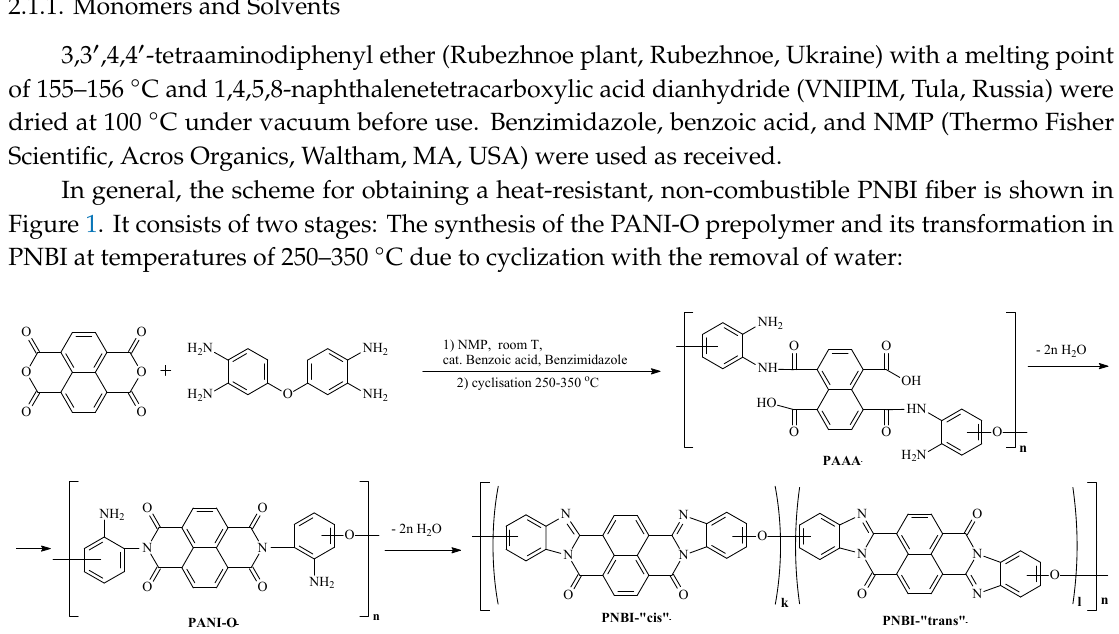
Figure 1. Scheme of polynaphthoylenebenzimidazole (PNBI)